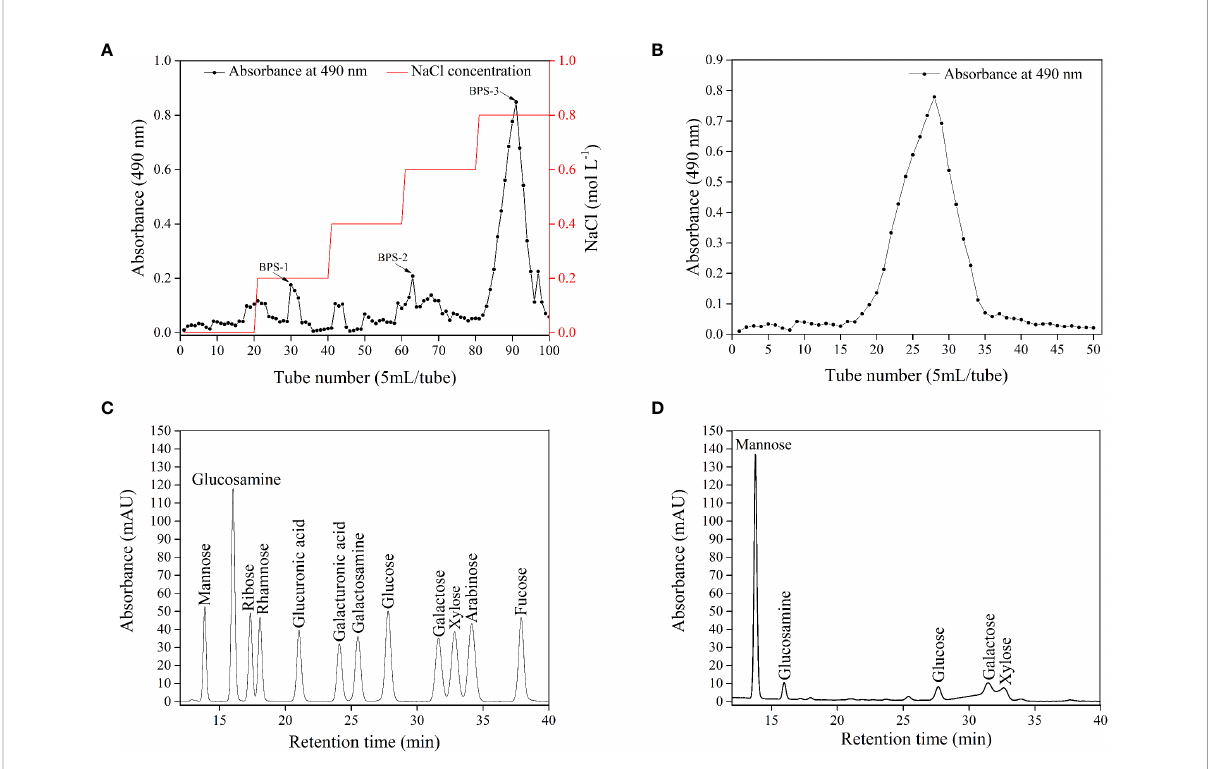
FIGURE 3 Elution pro fi le of crude BPS on Cellulose column (A) and Sepharose column (B) . HPLC chromatograms of standard monosaccharide (C) and BPS (D)